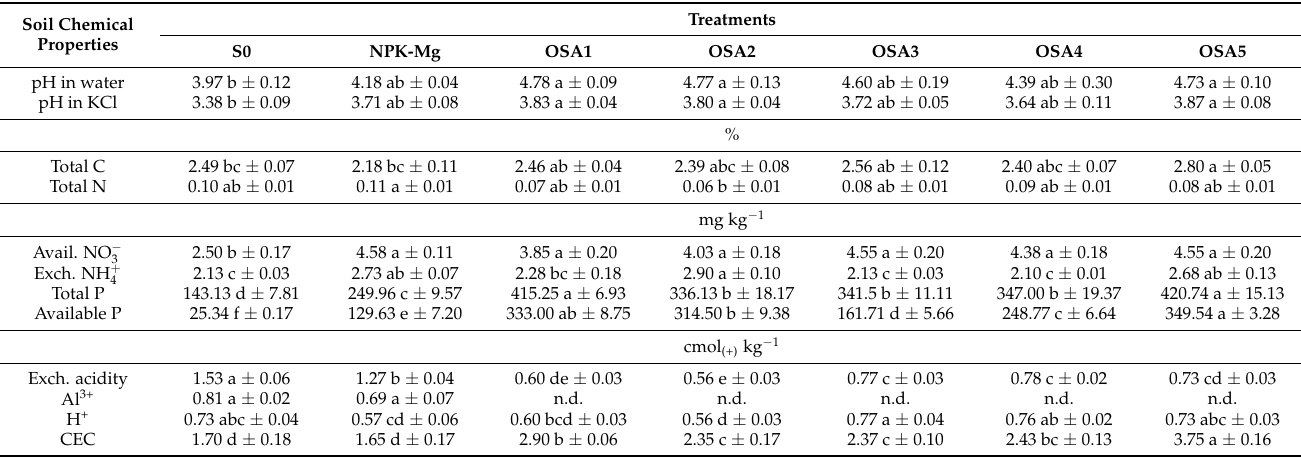
Table 5. Effects of organic soil amendments on chemical properties of Nyalau series soil after the first cropping cycle of rice